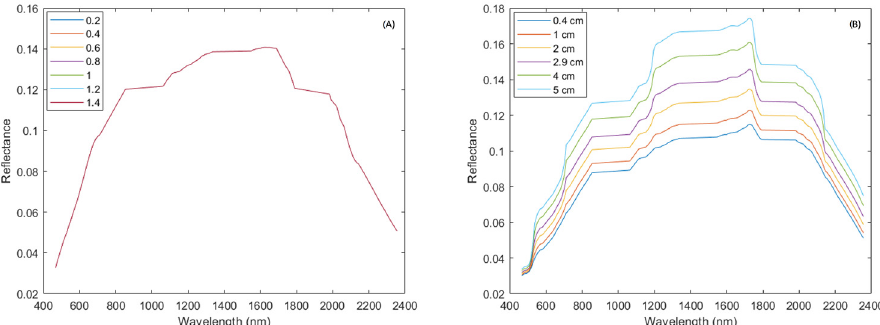
Figure 6. Spectral signature of the same bare soil pixel corrected by ( A ) FLAASH with varying AOD levels and ( B ) ATCOR with varying WV levels.